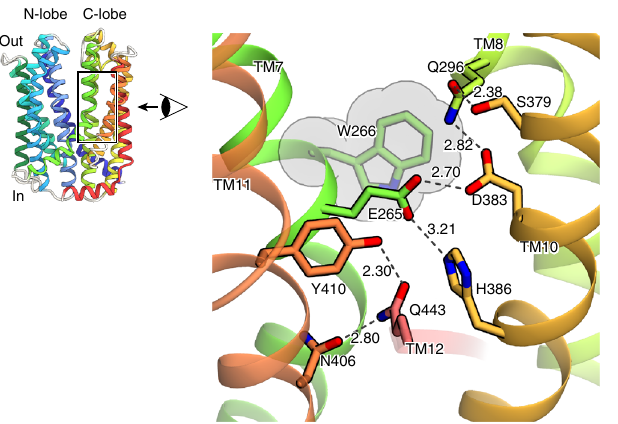
Fig. 4 Hydrogen-bonding network in the C-lobe. Close-up view of the C-lobe hydrogen-bonding network is shown. The dashed lines indicate the hydrogen-bonding network. Trp266 is represented by a CPK model (gray)